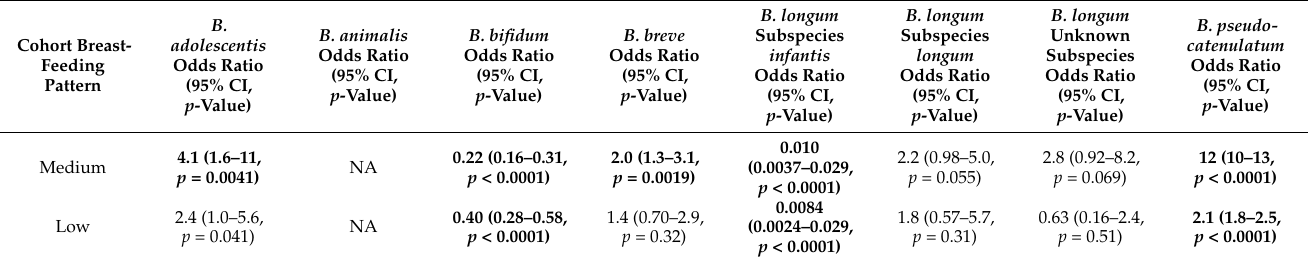
Table 3. Summary of GEE models comparing presence or absence of Bifidobacterium species in individual infants by cohort history of breastfeeding. Reference group was the high-breastfeeding group. To account for multiple comparisons, a p -value less than 0.0062 is considered significant. The model for B. animalis failed to run, because after excluding infants who were not breastfed at time of sample collection, there were no infants from a low historical breastfeeding pattern cohort colonized by B. animalis. Taxa that differed significantly in prevalence from the high historical breastfeeding pattern cohorts are in